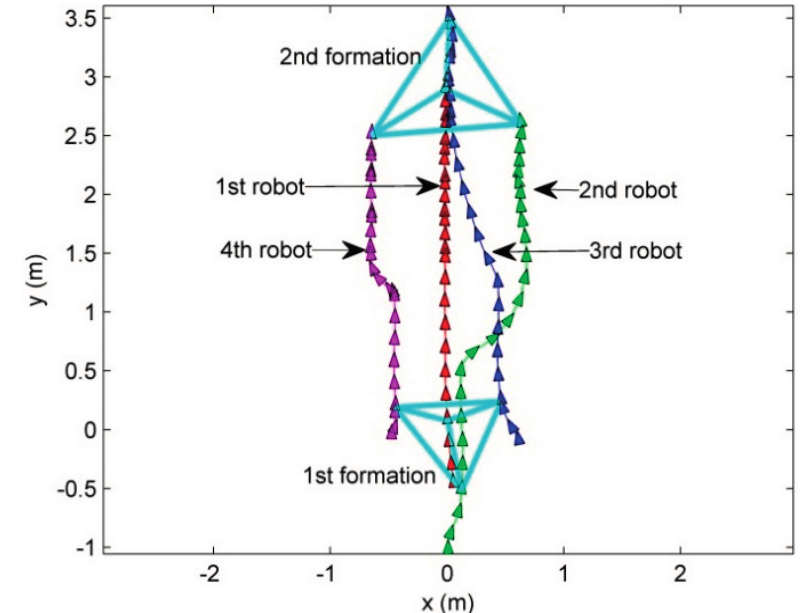
Figure 17. The routes of the robots in the situation of the formation